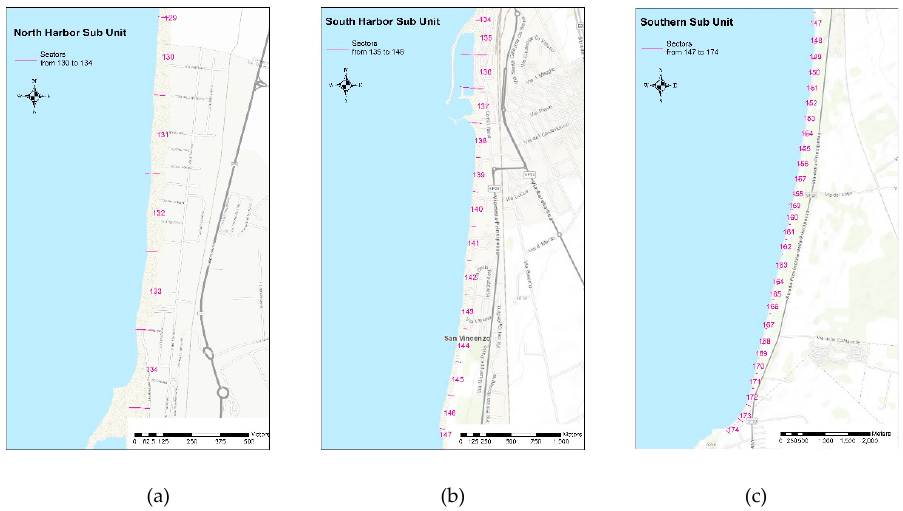
Figure 3. San Vincenzo’s subunit partition; ( a ) North Harbor Sub Unit; ( b ) South Harbor Sub Unit; ( c ) Southern Sub Unit.